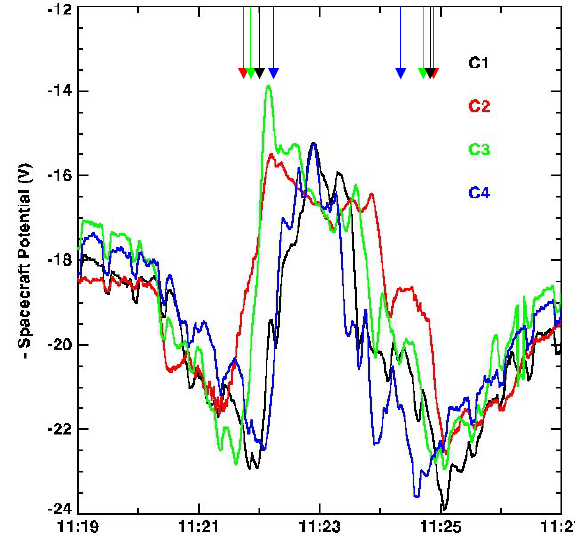
Fig. 10. The spacecraft potentials in the interval shown in Fig. 8, measured by the EFW instruments on spacecraft C1 (black), C2 (red), C3 (green) and C4 (blue). The arrows correspond to those plotted in Fig.